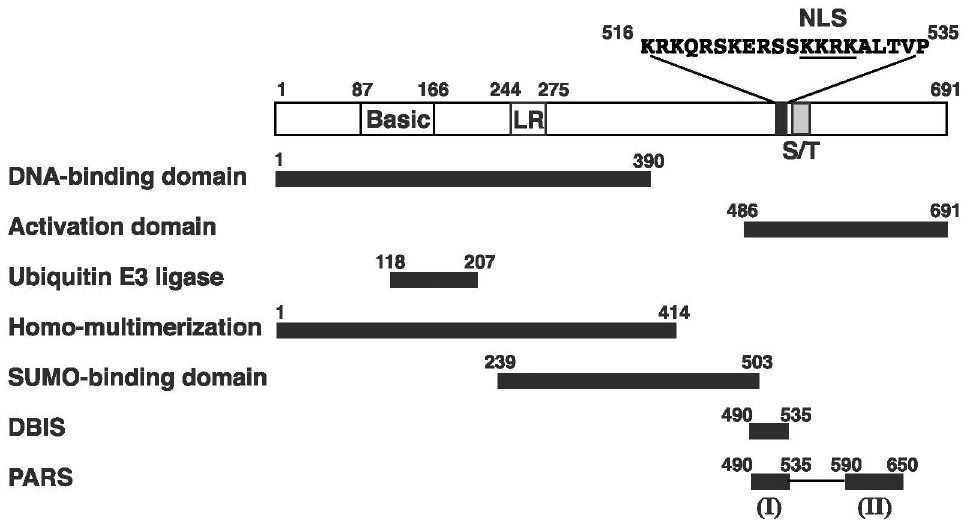
Fig 1. Structural and functional domains of ORF50 protein. Numbers in the diagram correspondto amino acid positions. NLS, nuclear localizationsignal; Basic, basic-richregion; LR, leucine heptapeptide repeat; S/T, serine/threonine-richregion. Distinct functional domains or regulatory motifs are shown, including the DNA- bindingdomain, activation domain, ubiquitin E3 ligase domain, homo-multimerization domain, SUMO-binding domain, DNA-binding inhibitorysequence (DBIS), and protein abundanceregulatory signal (PARS). The PARS contains two components located in aa 490–535(PARS-I) and aa 590–650(PARS-II), respectively.